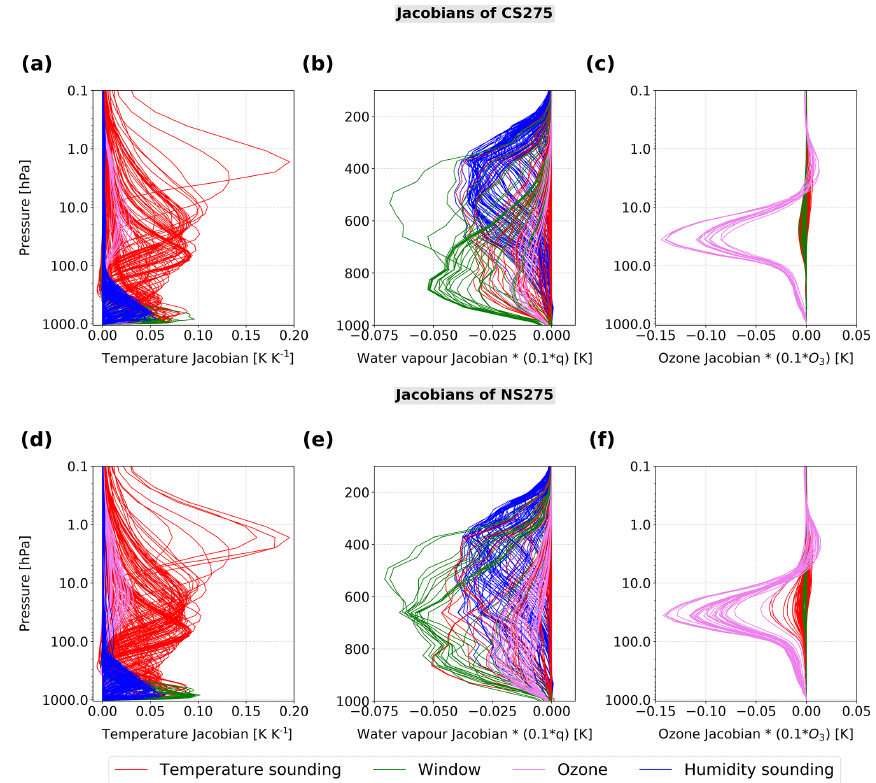
Figure 11. Comparison between mean Jacobians of Collard’s channel selection (275) for temperature (a) , water vapour (b) , ozone (c) and mean Jacobians of new channel selection (275) for temperature (d) , water vapour (e) and ozone (f) . The red, green, purple and blue lines represent the channels sensitive to temperature sounding, window, ozone and humidity sounding, respectively. Note that the water vapour Jacobians (b) and (e) are only shown between 1000 and 100hPa.